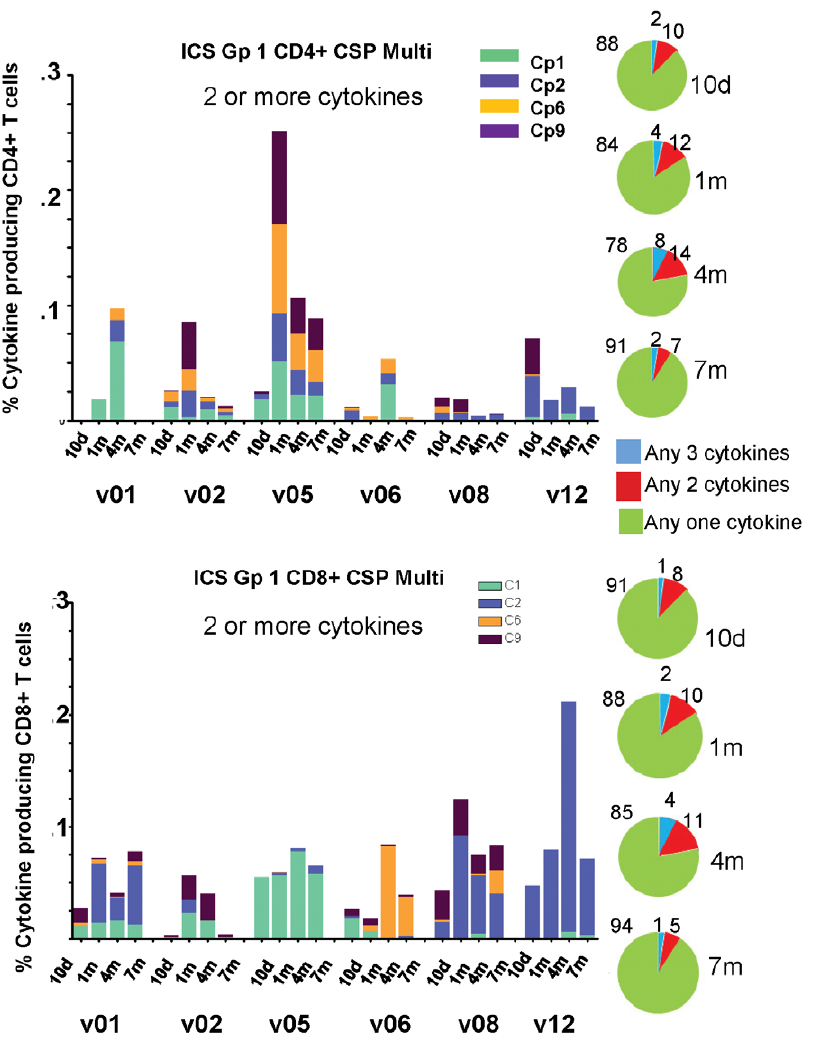
Figure 9. Multifunctional CD4 + and CD8 + T cells of serial bleeds of volunteers in Group 1 with CSP peptide pools. A and C : Multifunctional (any two cytokines) CD4 + and CD8 + T cell activities of each volunteer at 10 d, 1, 4, and 7 m after immunization (subtracting pre- immunization values) are displayed using color-coded CSP peptide pools. At 1 month, CD4 + multi responses (geomean 0.027% CD4 + T cells, std dev 953) and CD8 + multi responses (geomean 0.06% CD8 + T cells, std dev 346) were similar. B and D : Pie charts representing the proportion of the cytokine response indicated by cytokine subsets as shown; numbers on pie charts represent percent of that subset of the total cells.